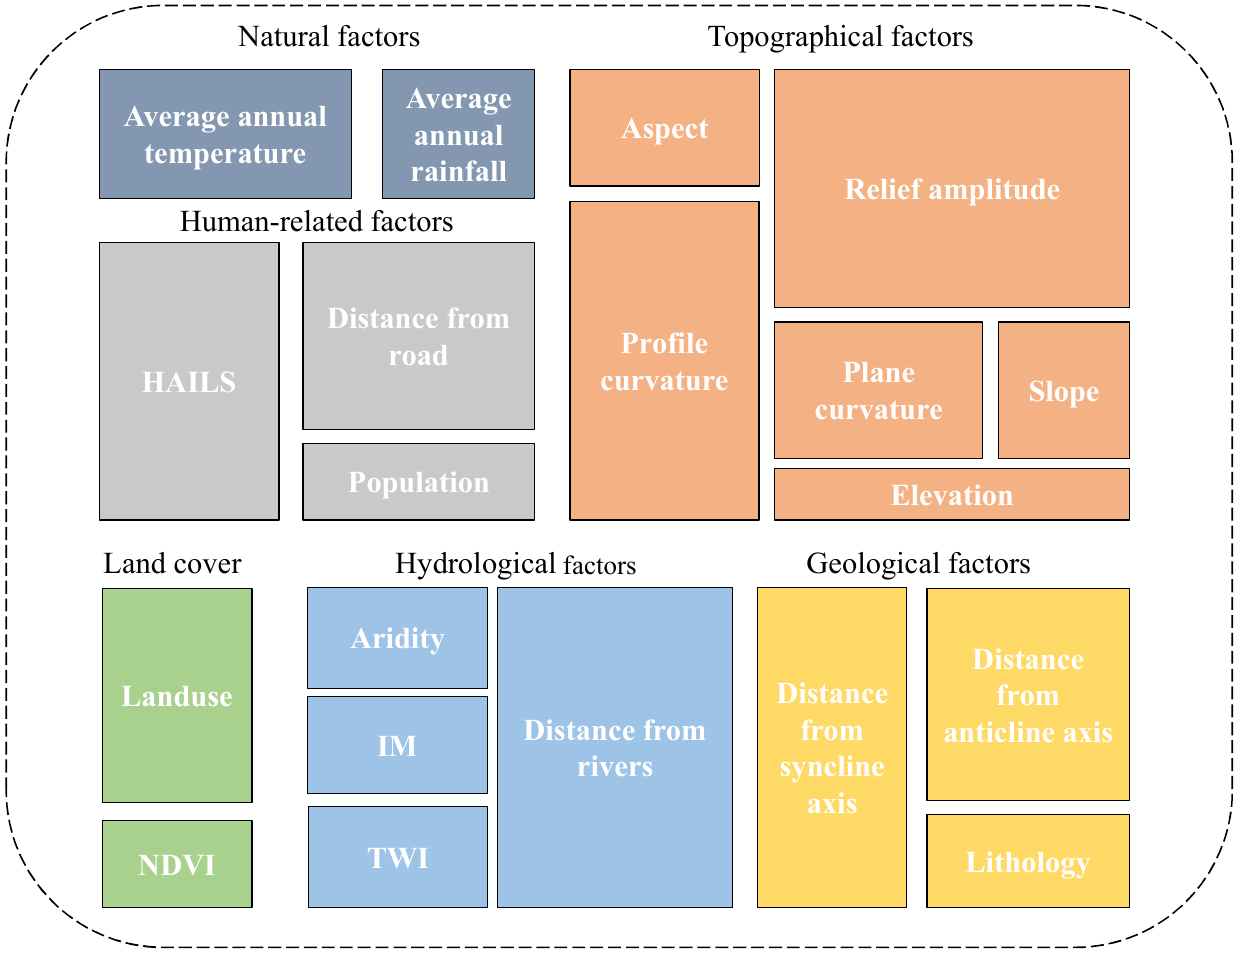
Figure 6. Conditioning factor types.